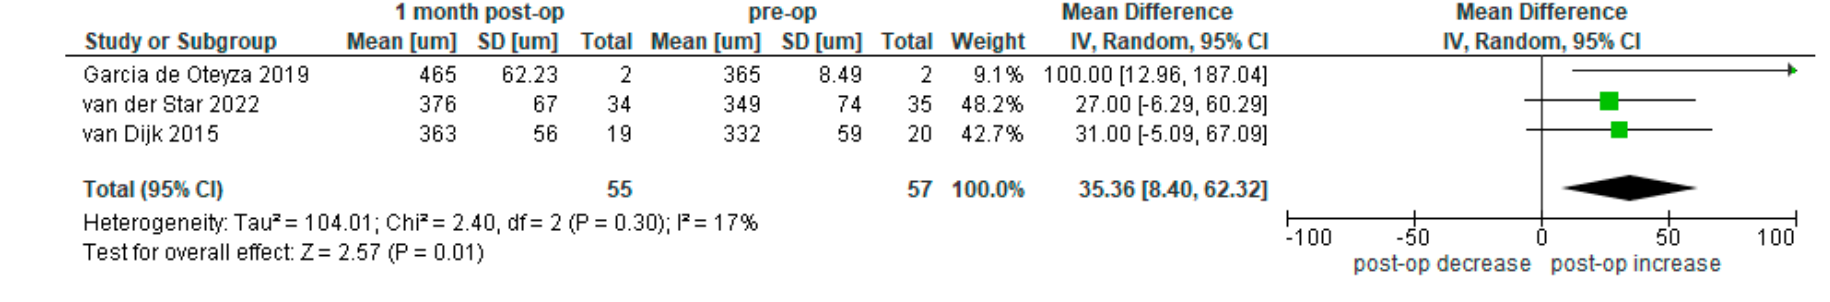
Figure A3. Di ff erence in pachymetry thinnest point across 3 studies [28,31,43]. Figure A3. Difference in pachymetry thinnest point across 3 studies [28,31,43].